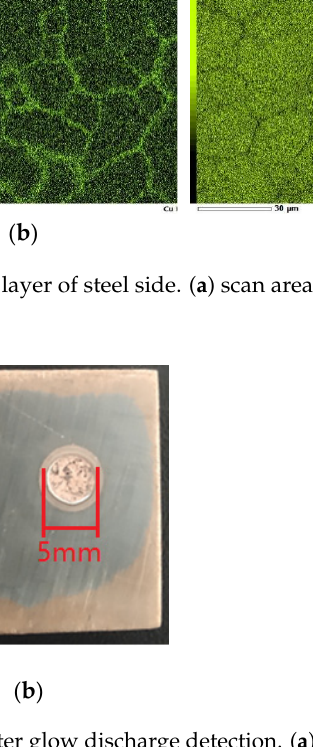
Figure 6. Sample morphology before and after glow discharge detection. ( a ) before and ( b ) after. The distribution of elements Cu and Fe of the transition layers for the samples at different casting temperature had been tested by the glow discharge instrument. The re ‐ sults are shown in Figure 7a–e, wherein the content of Cu and Fe is the mass percentage.